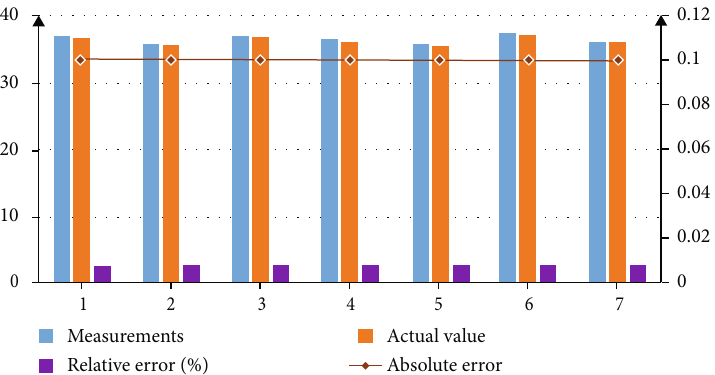
Figure 4: Body temperature measurement accuracy analysis.